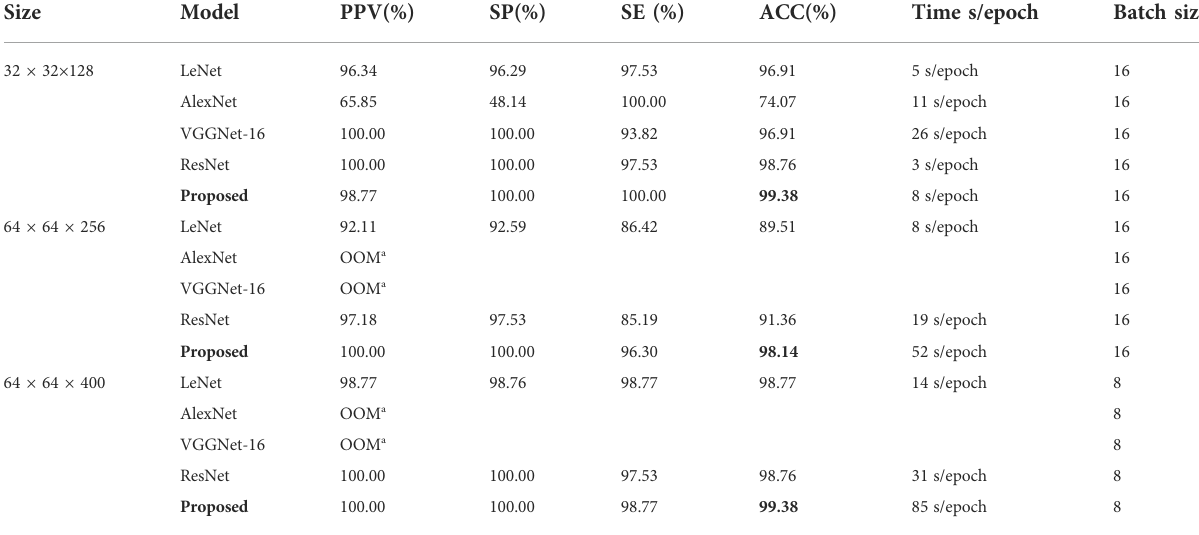
TABLE 3 Comparison of balanced random prediction performance with different network